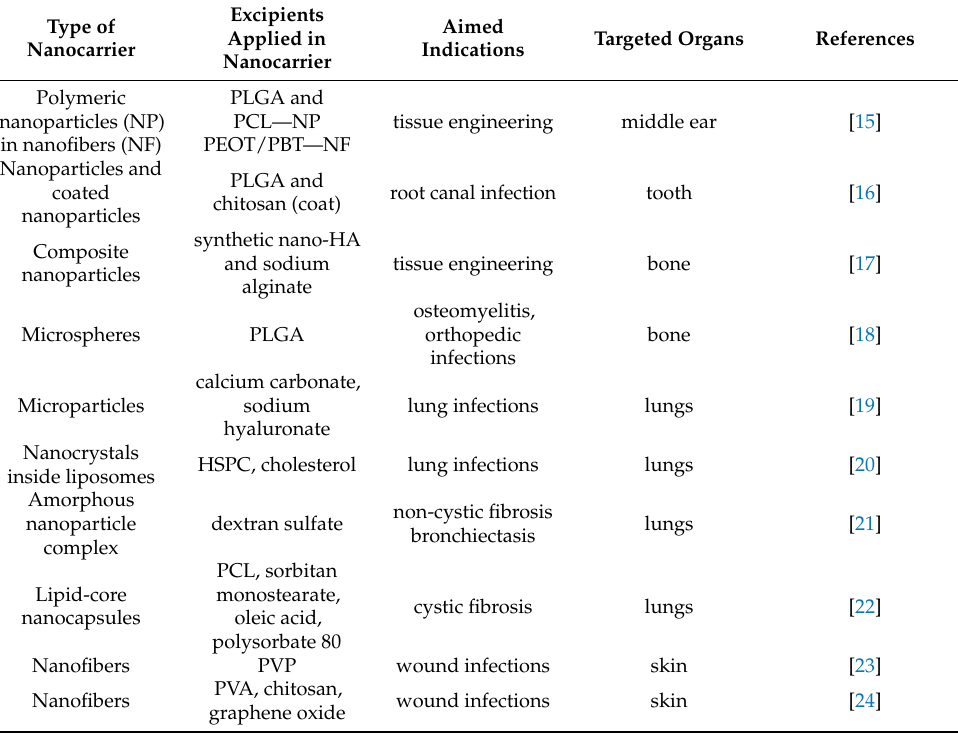
Table 1. Ciprofloxacin-loaded nanocarriers under investigation with the aimed